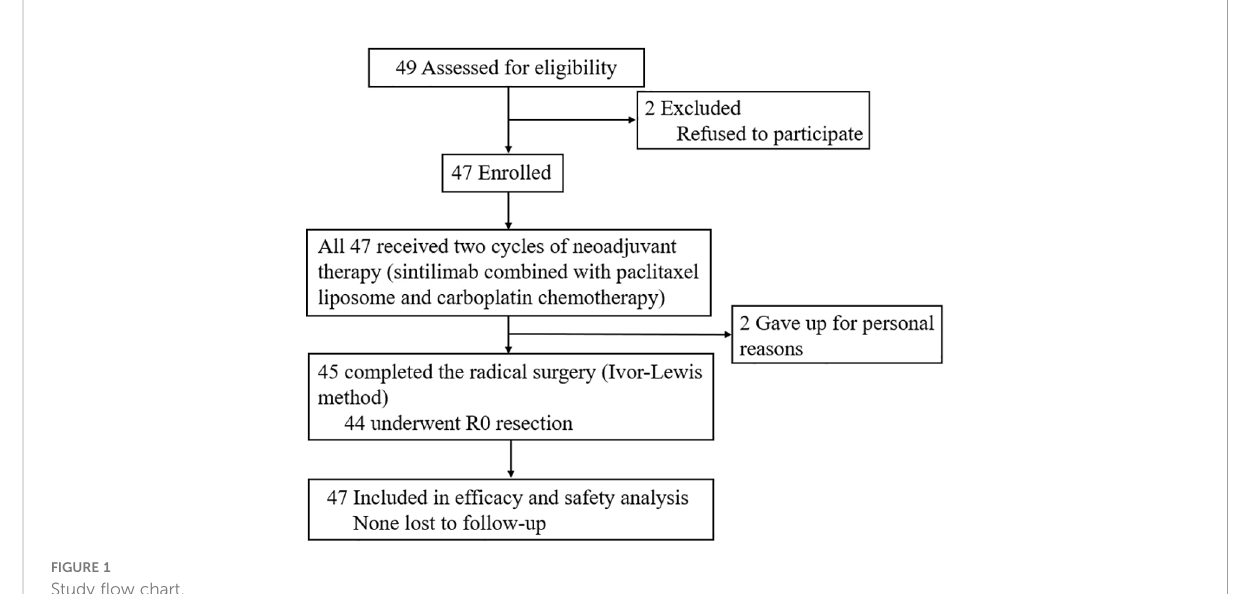
FIGURE 1 Study fl ow